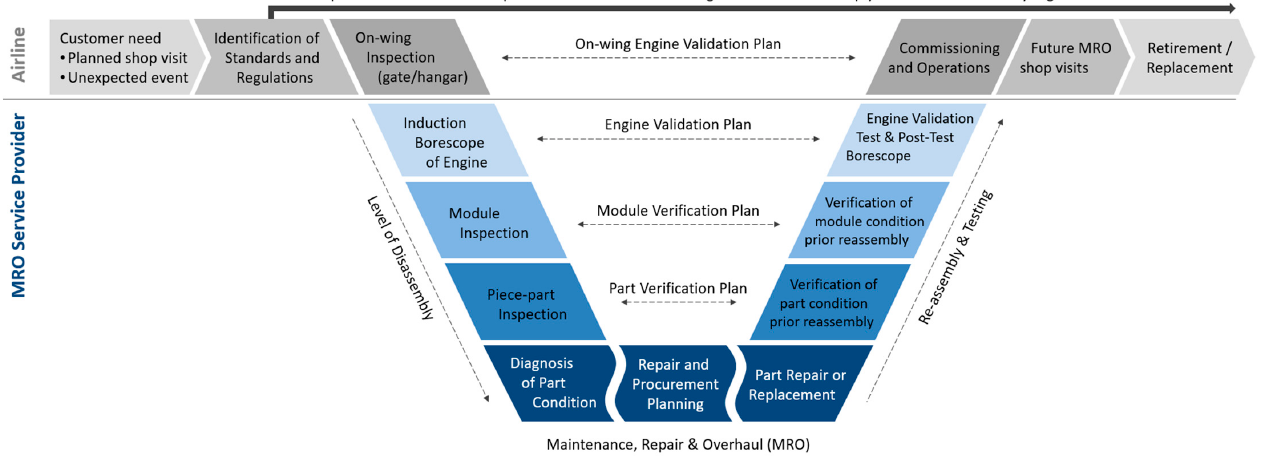
Figure 1. Inspection workflow and hierarchy of levels of inspection.